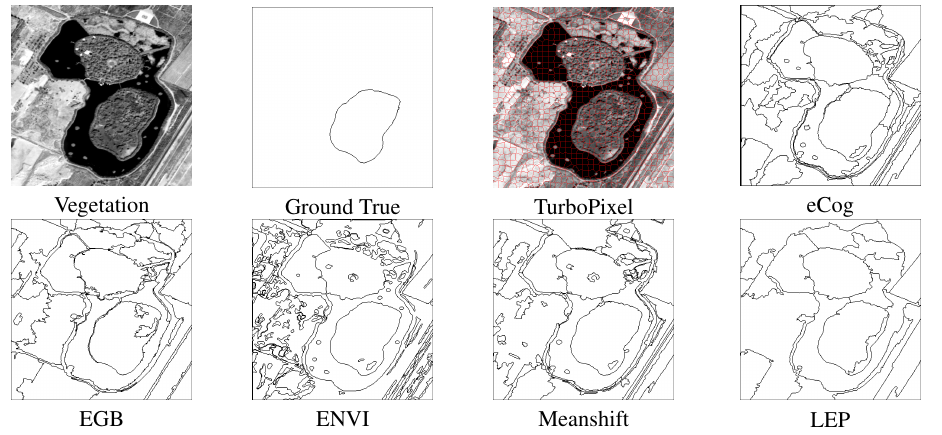
Figure 6: Vegetation segmentation results, with the GHD values shown in Table